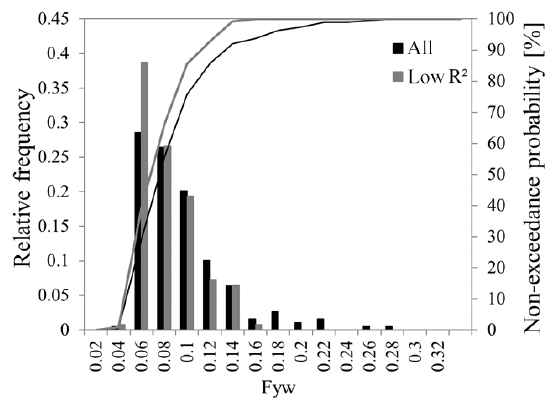
Figure 5. Histograms and cumulative distribution functions of all Fyw(189) results (black) and of the results when the low R 2 is left out (low R 2 ; grey).